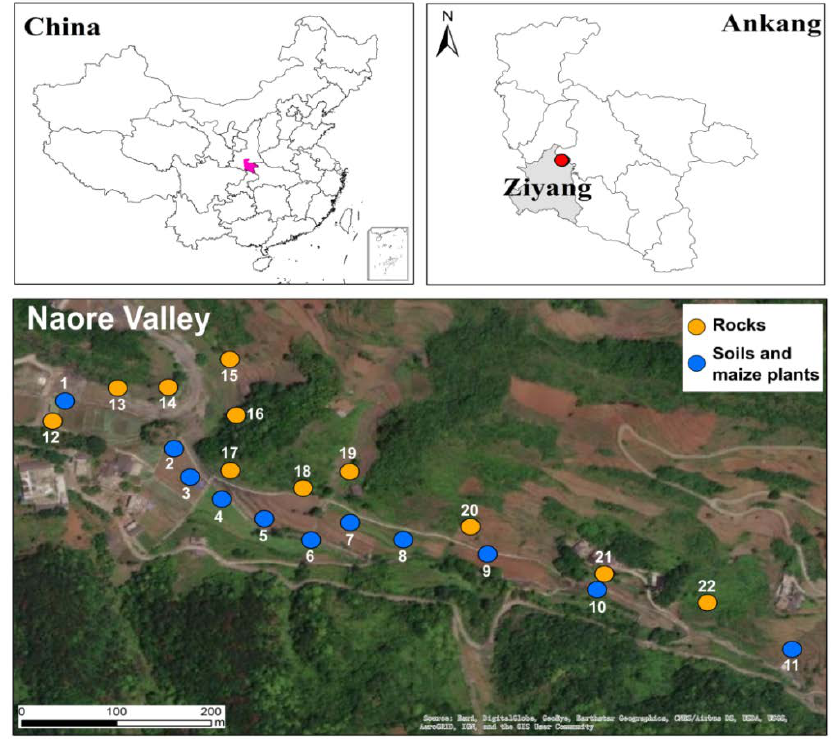
Figure 1. Location of the study area and sampling sites. Map of China based on GS(2019)182.